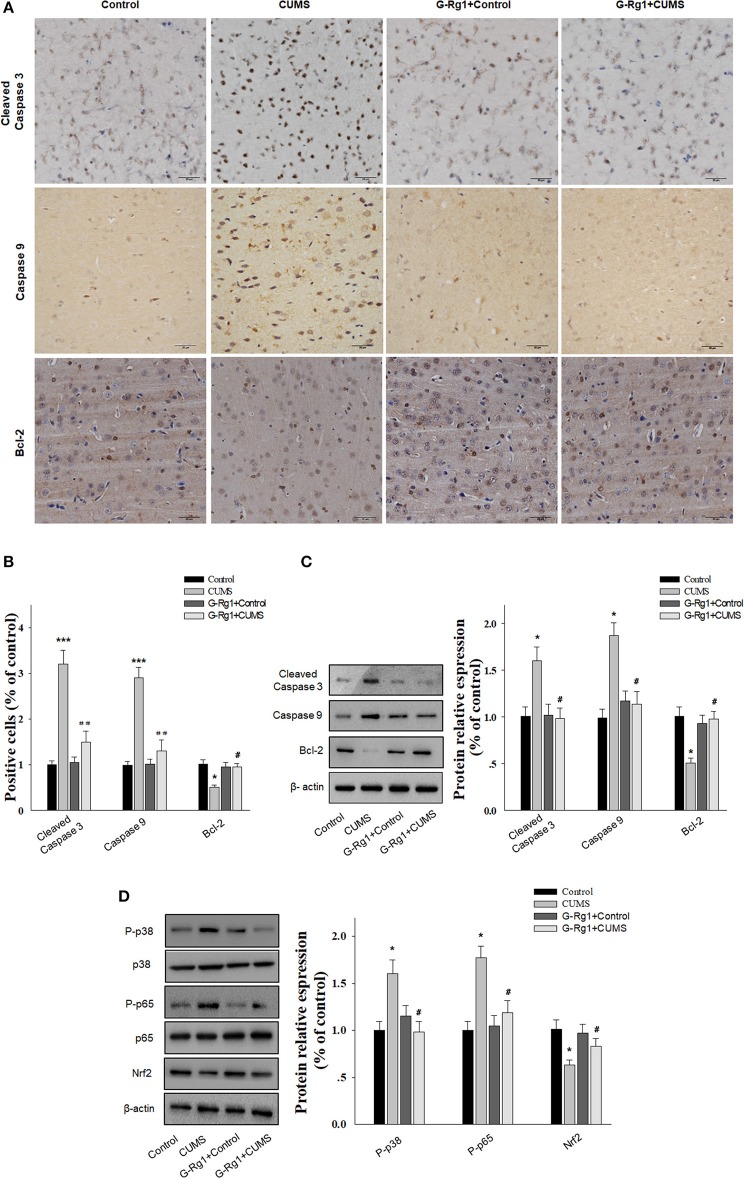
Ginsenoside-Rg1 suppressed the expression of apoptosis-related proteins within the vmPFC region as induced by CUMS-exposure. (A) Expression of cleaved caspase-3, caspase-9, and Bcl-2 within with the vmPFC region with use of immunohistochemical staining. Scale bar is 20 μm. (B) Bar graphs show quantification of cleaved caspase-3, caspase-9, and Bcl-2. Values are expressed relative to those of the control group. (C) Expression of cleaved caspase-3, caspase-9, and Bcl-2 within with the vmPFC region with use of Western Blot assays. (D) Expression of phosphorylated p38, p65, and Nrf2 within with the vmPFC region with use of Western Blot assays. N = 6 per group. Data were presented as the means ± SEM. *P < 0.05, ***P < 0.001 CUMS vs. Control group; #P < 0.05, ##P < 0.01 G-Rg1+CUMS vs. CUMS group. G-Rg1, Ginsenoside-Rg1.